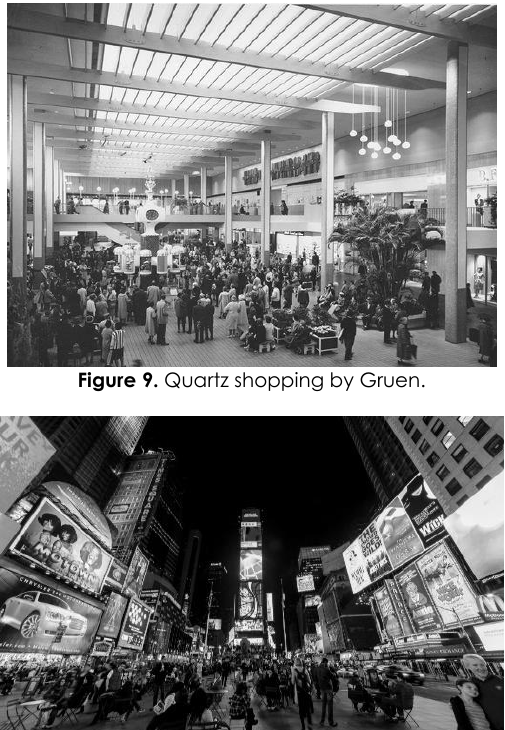
Figure 10. Times Square. New